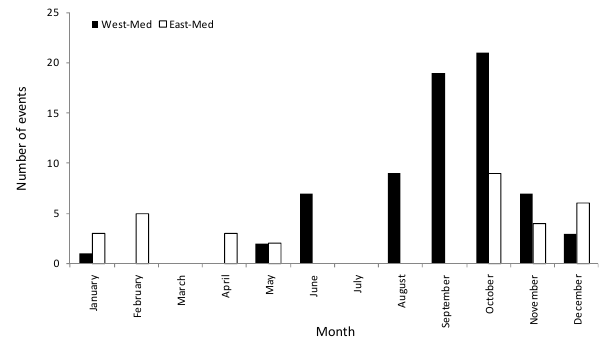
Fig. 3. Number of flash flood occurrences in each